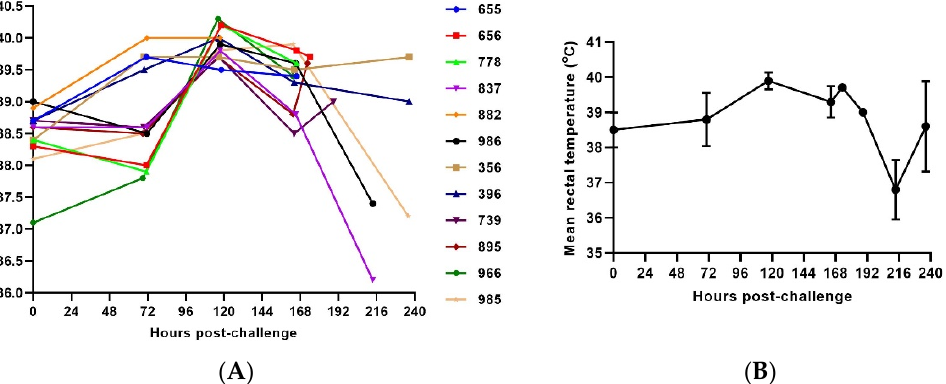
Figure 3. Rectal Temperature in SUDV challenged NHPs. ( A ) Rectal temperature in individual SUDV challenged animals versus time. ( B ) Group mean rectal temperature. The error bars represent the standard deviation (SD).